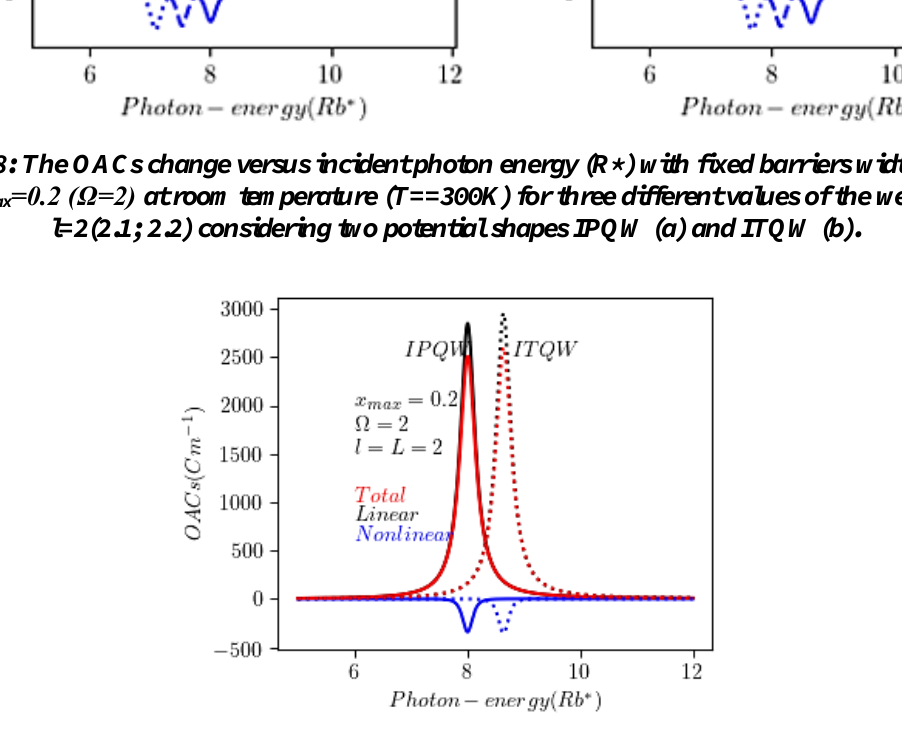
Figure 9: The OACs change of both IPQW and ITQW versus incident photon energy (R*) with fixed barriers/well widths (L=l=2) and x =0.2 (Ω=2) at room temperature max